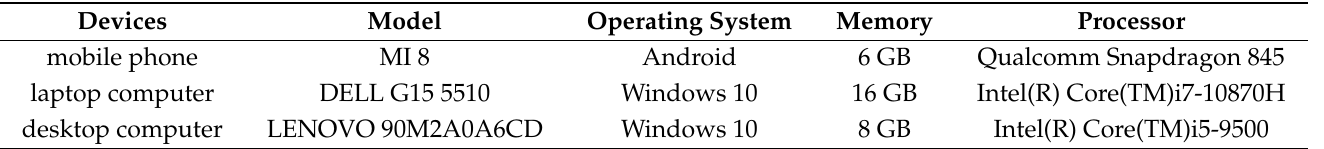
Table 4. Parameters of the